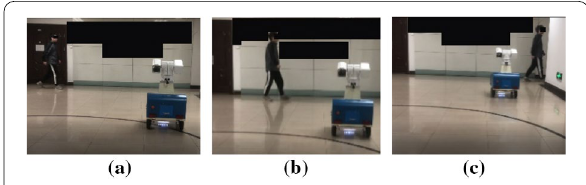
Figure 14 Crossing behavior pattern experiment: a approaching robot, b robot decelerates to avoid, c human